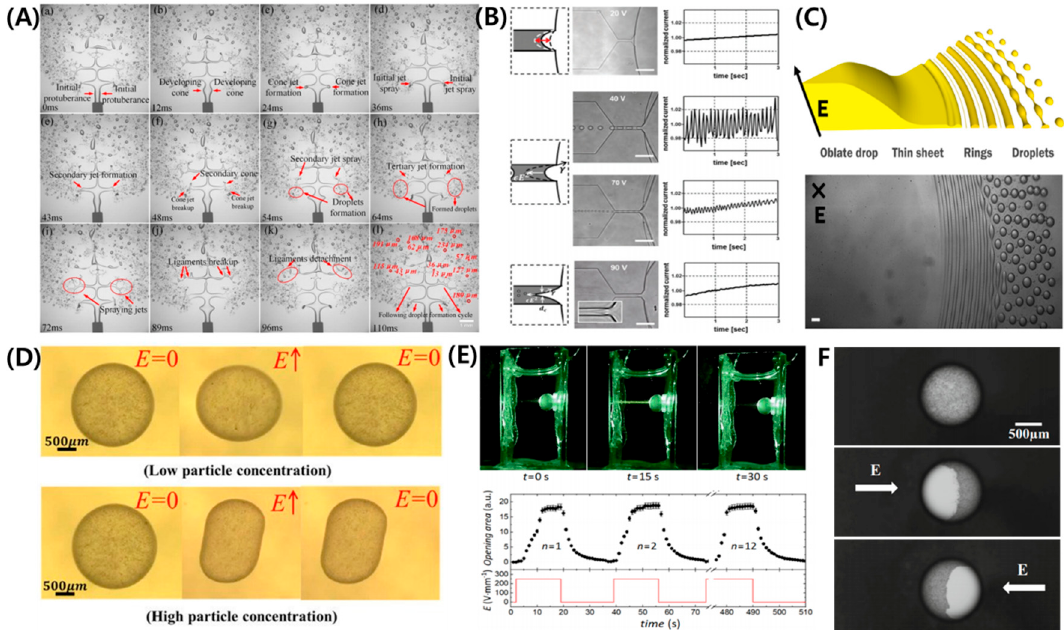
Figure 10. Applications of electro-hydrodynamics (EHD) of emulsion droplets. ( A ) Electric-field- induced breakup of a liquid column from a nozzle, and small droplet formation behavior [158] . ( B ) Electric production of emulsion droplets in a microfluidic system [161] . ( C ) Droplet generation via streaming from the equator of a drop in an electric field [18] . ( D ) Stabilizing the shape of deformed colloidal particles by the interfacial jamming of nanoparticles [121] . ( E ) Optical diaphragm based on the particle self-assembly [162] . ( F ) Generation of an aluminum Janus particle using an electric field